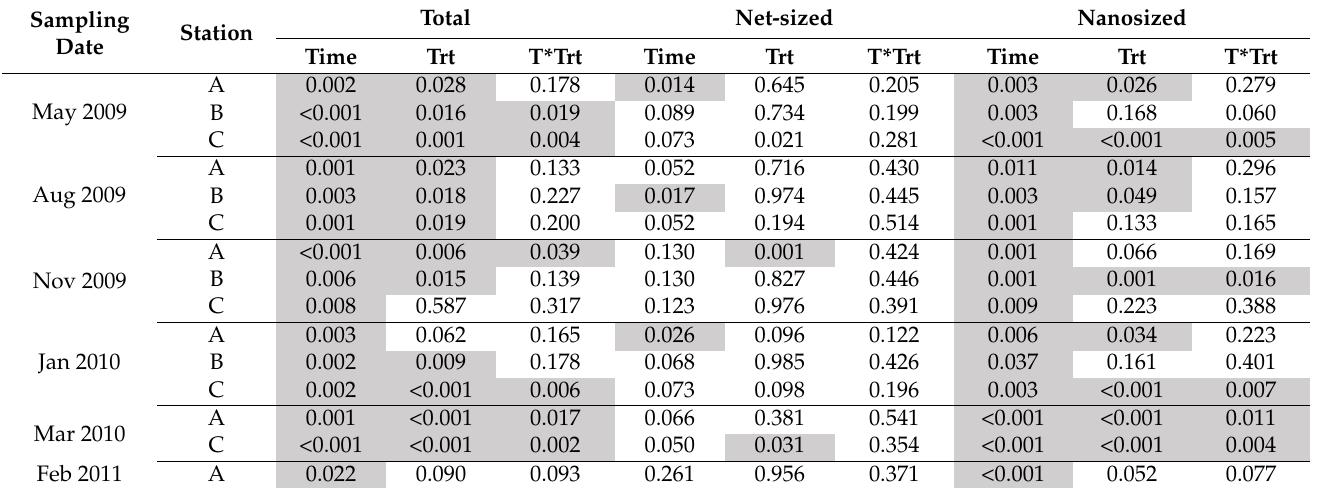
Figure 4. Size-fractionated chl a concentration ( µ g L − 1 ) and contribution percentage (%) of nanosize class during the mesocosm experiments for water samples collected at Sts. A and C in March 2010 and at St. A in February 2011. Treatments of 2.5, 5, and 10 ppm HA (Sigma ‐ Aldrich ® ) and 5 ppm HA obtained from IHSS were designed for the experiments in March 2010 and February 2011, re ‐ spectively. Table 3. Results of the RM-ANOVA analyses on HA addition treatments for total, net-, and nanosized phytoplankton at a significance level of 0.05. Time and Trt (treatment) represent the differences over time and between the treatments (control vs. HA (5 ppm) addition), respectively and T*Trt represents differences between the treatments and over time. Significant p -values (<0.05) are highlighted in gray.